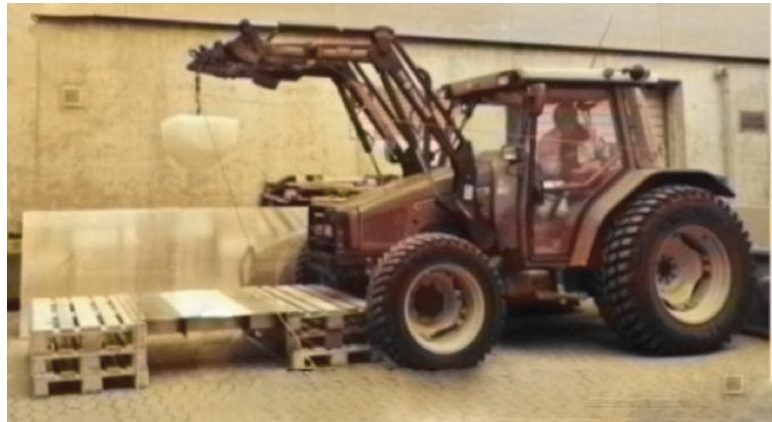
Figure 14. Photographs of the drop test experiment.